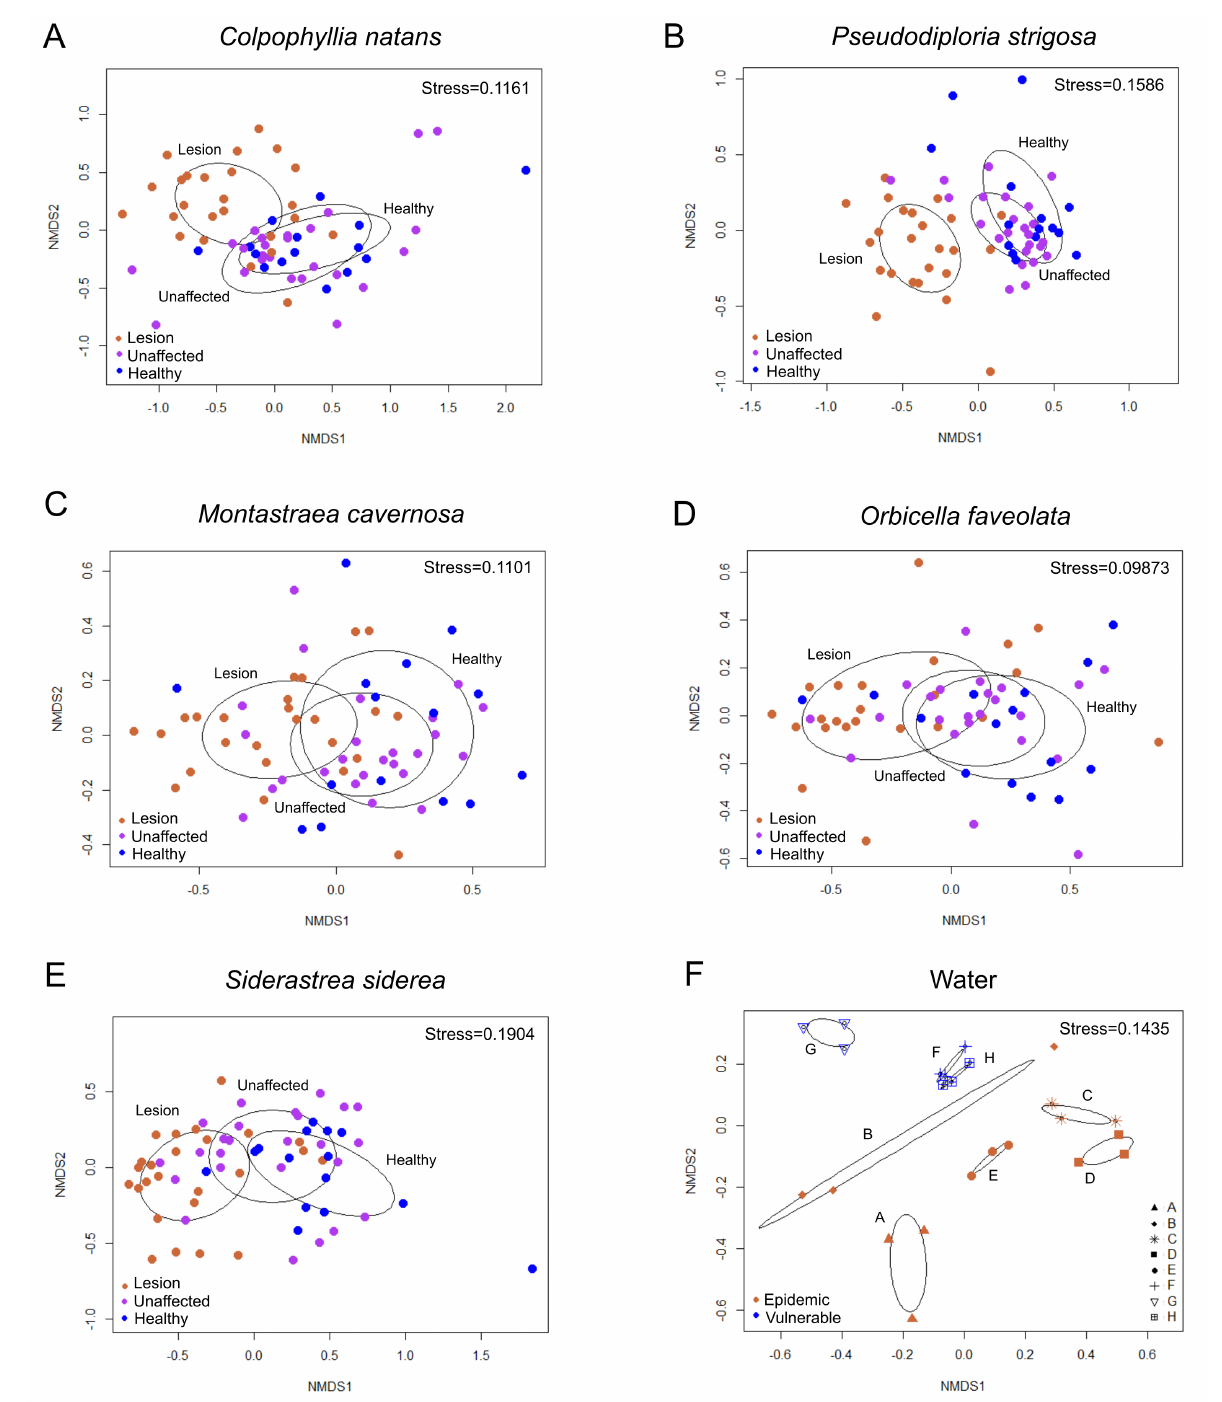
Figure 4. Non-metric Multidimensional Scaling (NMDS) ordination plots of amplicon sequence variants (ASVs) in lesion tissue (orange) and unaffected tissue (purple) of colonies with stony coral tissue loss disease, and tissue of apparently healthy colonies (blue) of five coral species: ( A ) Colpophyllia natans , ( B ) Pseudodiploria strigosa , ( C ) Montastraea cavernosa , ( D ) Orbicella faveolata , and ( E ) Siderastrea siderea . These data reflect samples collected in the epidemic zone. NMDS ordination plots of ASVs in ( F ) water samples reflect samples collected in the epidemic zone (Sites A–E; orange) and vulnerable zone (Sites F–H; blue). NMDS was performed using a Euclidean